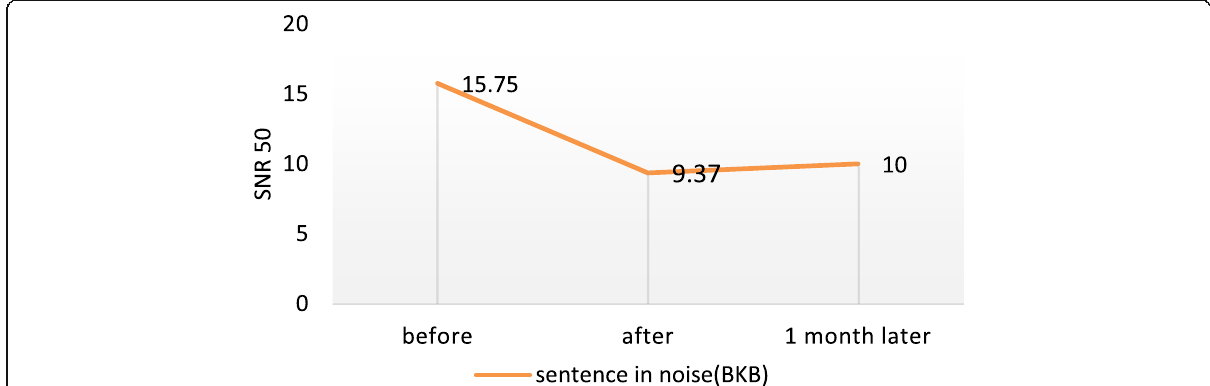
Fig. 5 The results of the repeated measures test showed that the mean score of “ sentence in noise ” had a statistically significant difference in three measurements ( P .value < 0.05). The Tukey test showed that there was a statistically significant difference between the first score and the second score ( P .value < 0.05), while there is no statistically significant difference between the second score and the third score ( P .value <